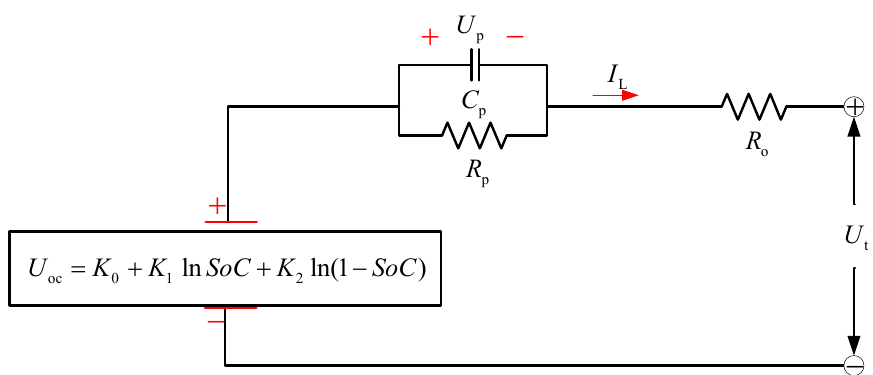
Figure 1. Schematic diagram for the new electrochemical-polarization